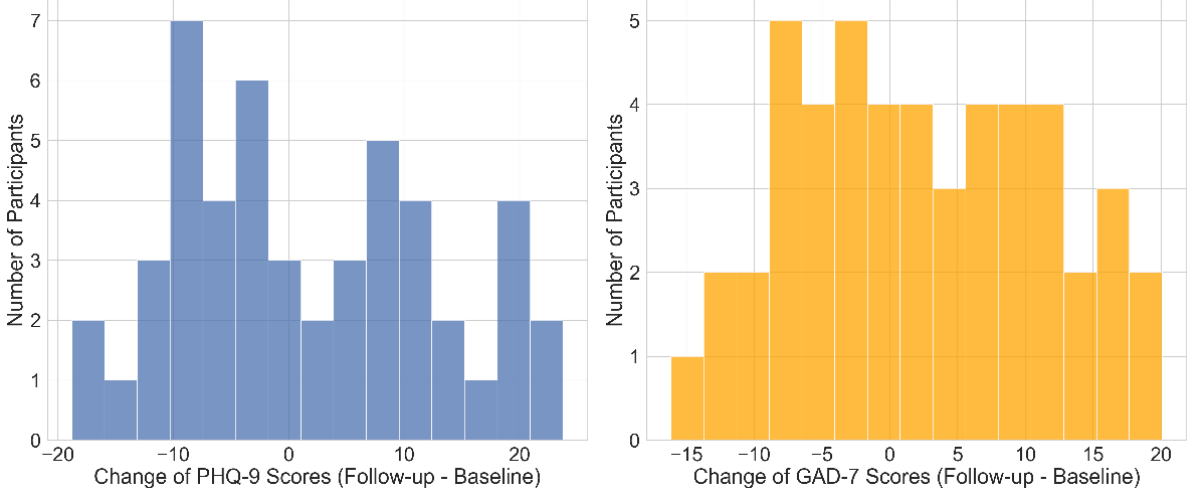
participants were US citizens, and the rest (n=10) were international students. A complete breakdown of demographics with respect to the deteriorating anxiety and depressive disorders are given in Table 1.